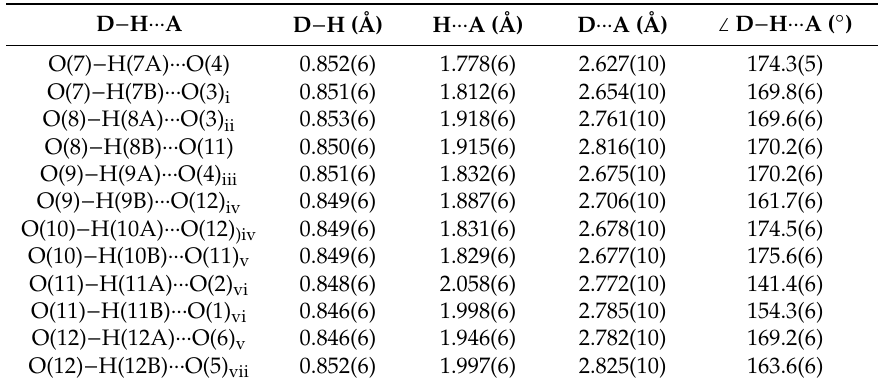
Table 3. The O–H ··· O hydrogen bonds for 1 1